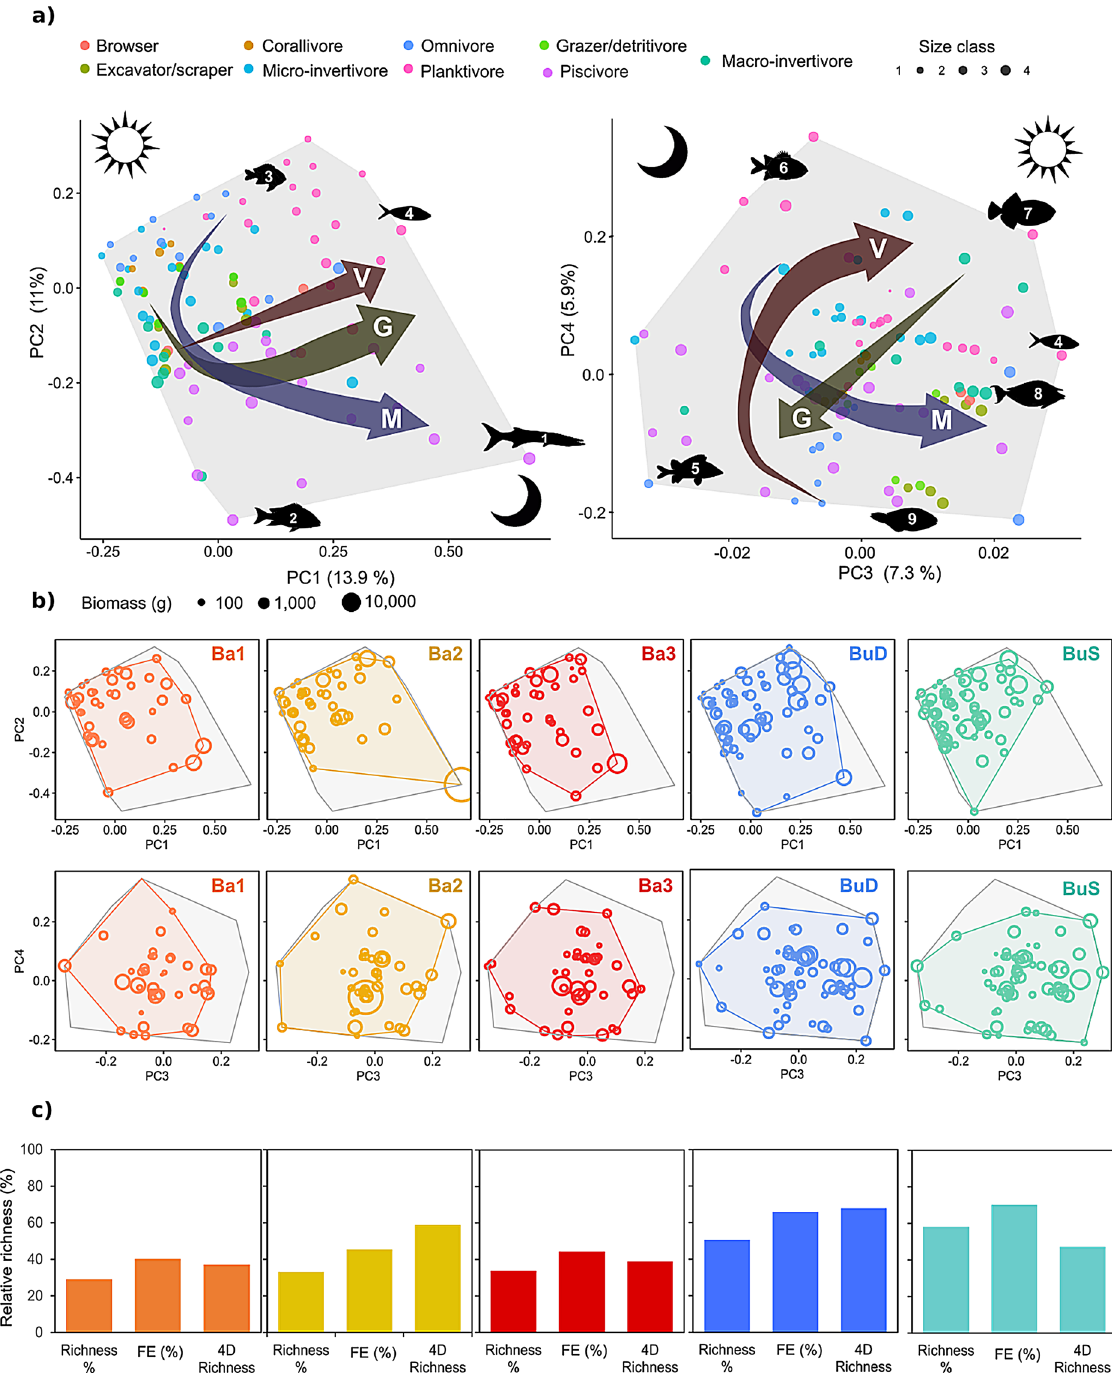
Figure 5. Fish functional diversity of the different communities identified. ( a ) Distribution of functional entities (FEs) in the global fish functional space, built using four PCoA axis (PC1 and PC2 left, PC3 and PC4 right) using six functional traits: body size, diet, period of activity, vertical position (V), gregariousness (G) and mobility (M). The numbers indicate the following functional entities: 1: Sphyraena quenie (Sphyraenidae), 2: big snappers (e.g., Macolor macularis, Lutjanidae), 3: damselfishes, 4: pelagic planktivores such as fusiliers (Caesionidae), 5: squirrelfishes ( Sargocentron spp., Holocentridae), 6: soldierfishes ( Myripristis spp., Holocentridae), 7: Melichthys vidua , 8: unicornfishes ( Naso spp., Acanthuridae). ( b ) Functional spaces of each of the communities’ analysed (coloured convex hull) superposed to the global functional space (grey). The bubble sizes represent the FEs mean biomass at each of the regimes. ( c ) Functional diversity indices for each of the communities: relative taxonomic richness (Richness %), relative FE richness (FE %) and relative functional richness as % of filled global functional space (4D